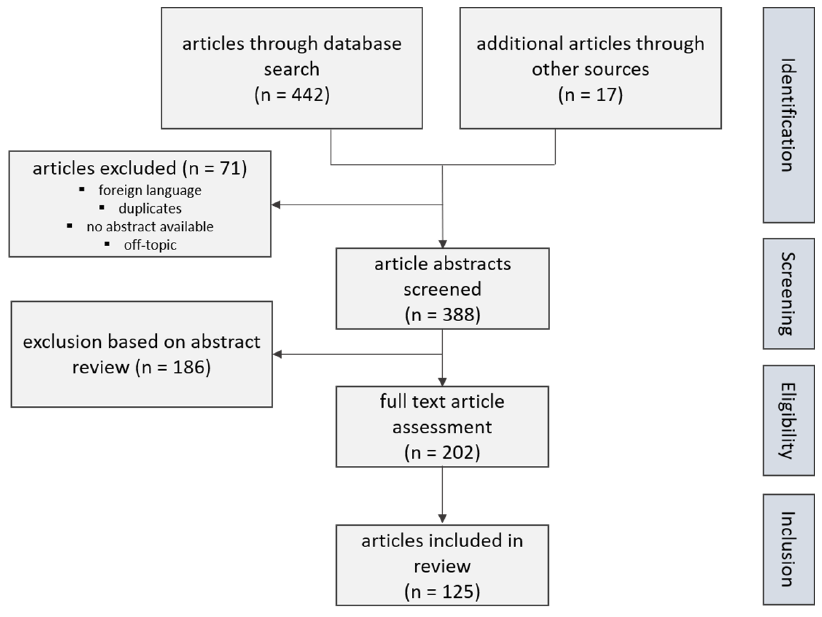
Figure 1. Workflow giving an overview of our literature search